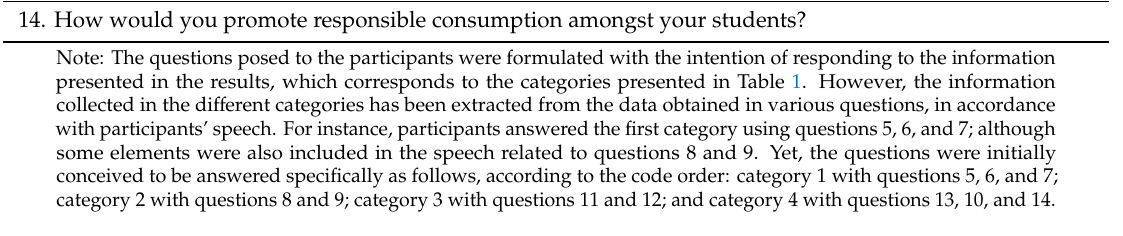
Table A2. Relationship between categories, codes, and frequency of quotes